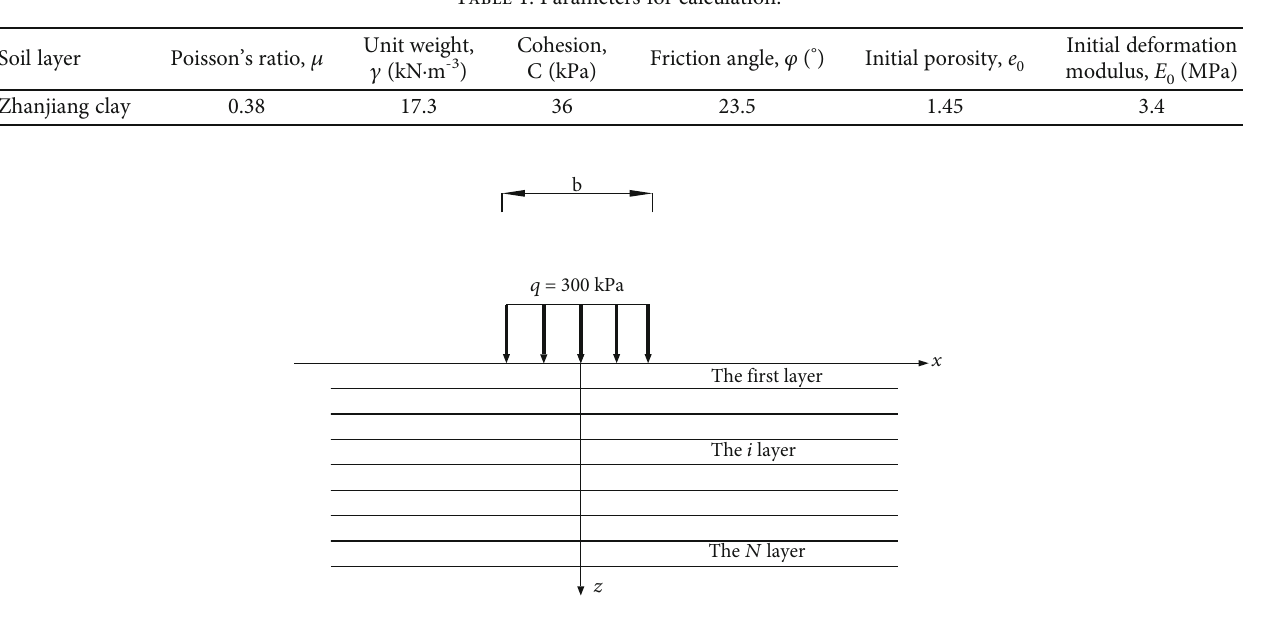
Table 1: Parameters for calculation.